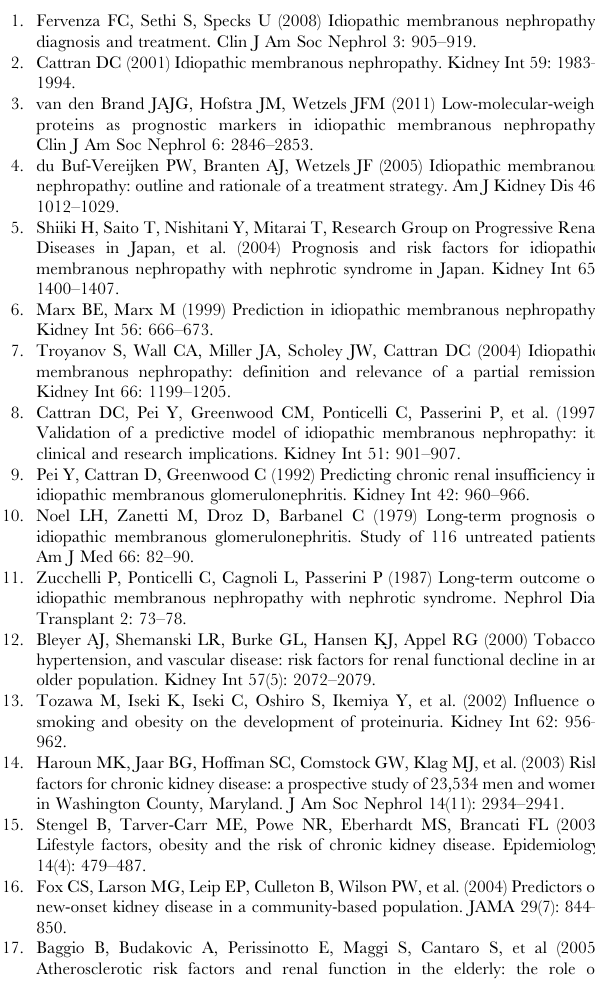
Table S2 Predictors of first CR. Table S3 Influence of smoking dose on first CR. Table S4 The anonymous data set of 171 patients with